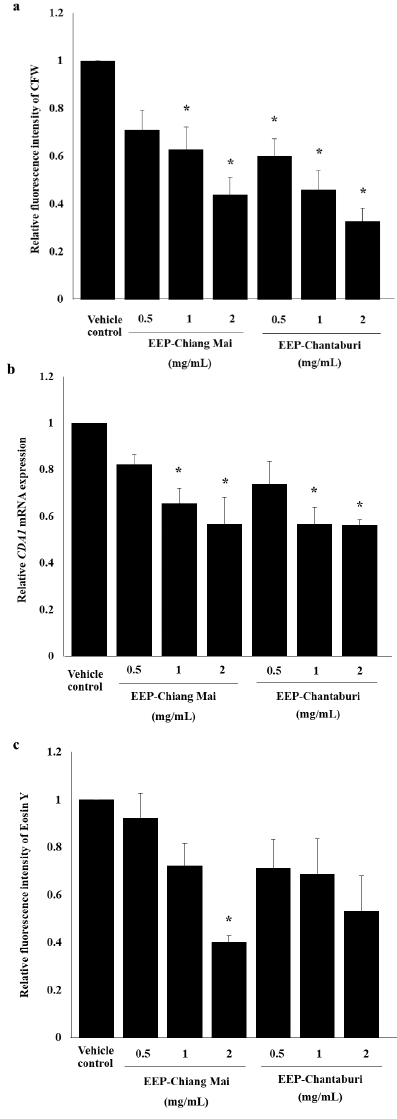
Figure 2. E ff ect of EEP on chitin / chitosan synthesis of C. neoformans . EEP-treated C. neoformans were incubated for 2 h. ( a ) The chitin content was determined by CFW staining and calculated to relative fluorescence intensity. ( b ) CDA1 mRNA expression by rRT-PCR. ( c ) The chitosan production was measured by EosinY staining. Significant di ff erences (* p < 0.05) were determined by one-way ANOVA and compared with the vehicle